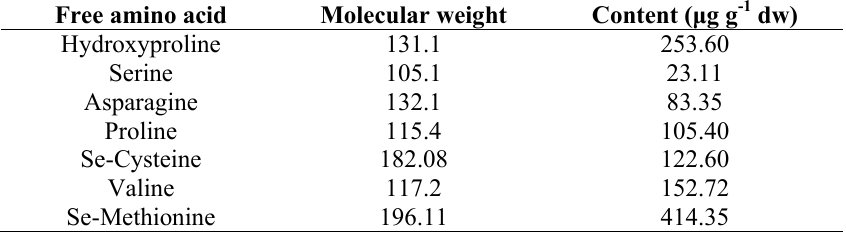
Table 4. Contents of free amino acids present in the water:ethanol extract of P. arborescens subsp. maderensis.